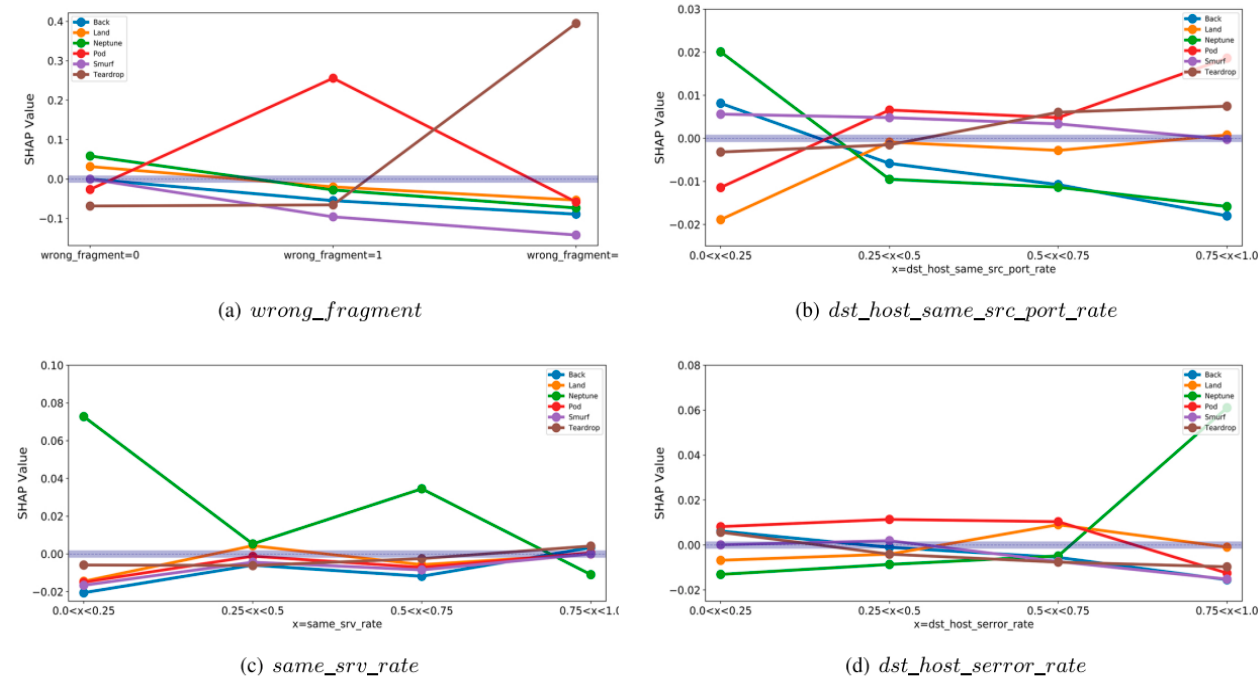
Figure 2. Relationships between the values of features and specific types of attacks.